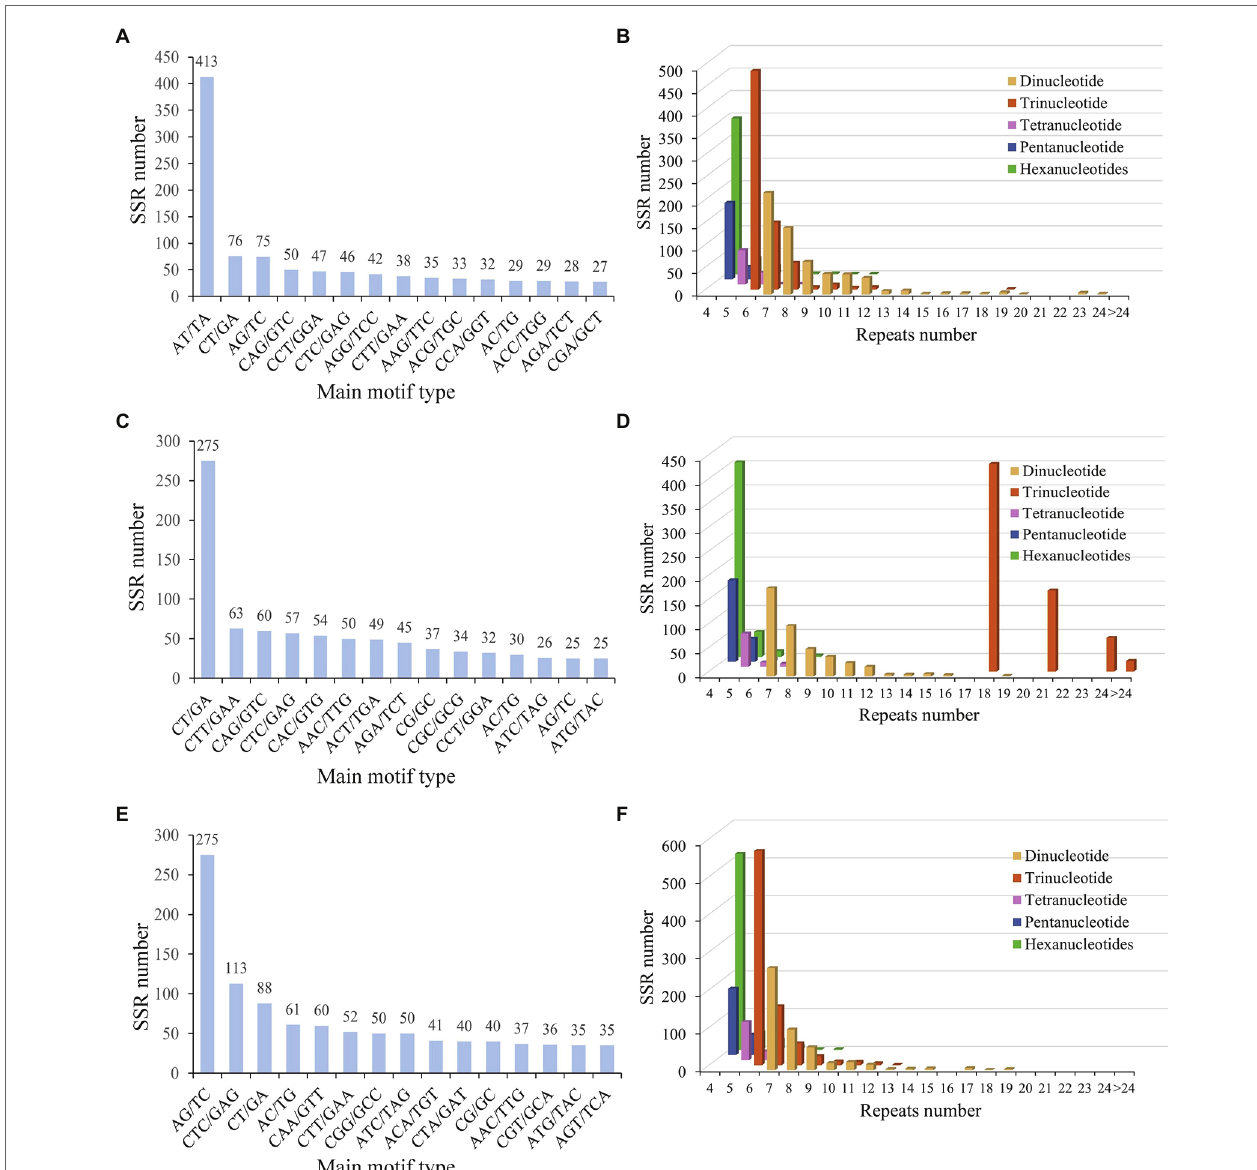
FIGURE 4 | The simple sequence repeat (SSR) distribution of three five-needle pines. SSRs length distribution across different motif classes in Pinus koraiensis (A) , Pinus sibirica (C) , and Pinus pumila (E) . The number of repeats in each different motif length in P. koraiensis (B) , P. sibirica (D) , and P. pumila (F)